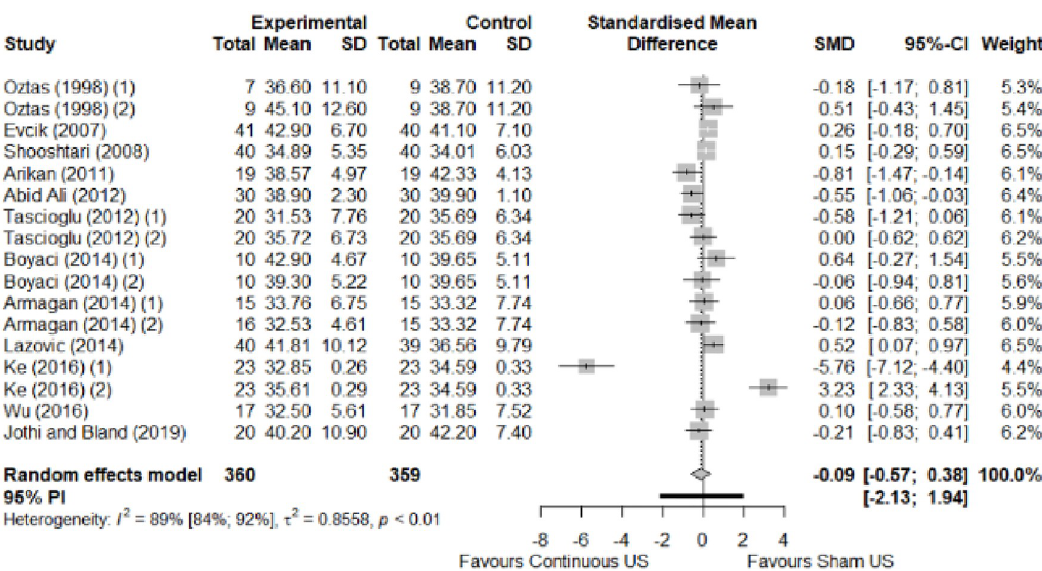
Fig 7. Analysis—Electrophysical modalities versus placebo (sensory velocity). Studies with more than two intervention groups (different modalities, treatment doses, or symptom classification) were numbered as (1) and (2).